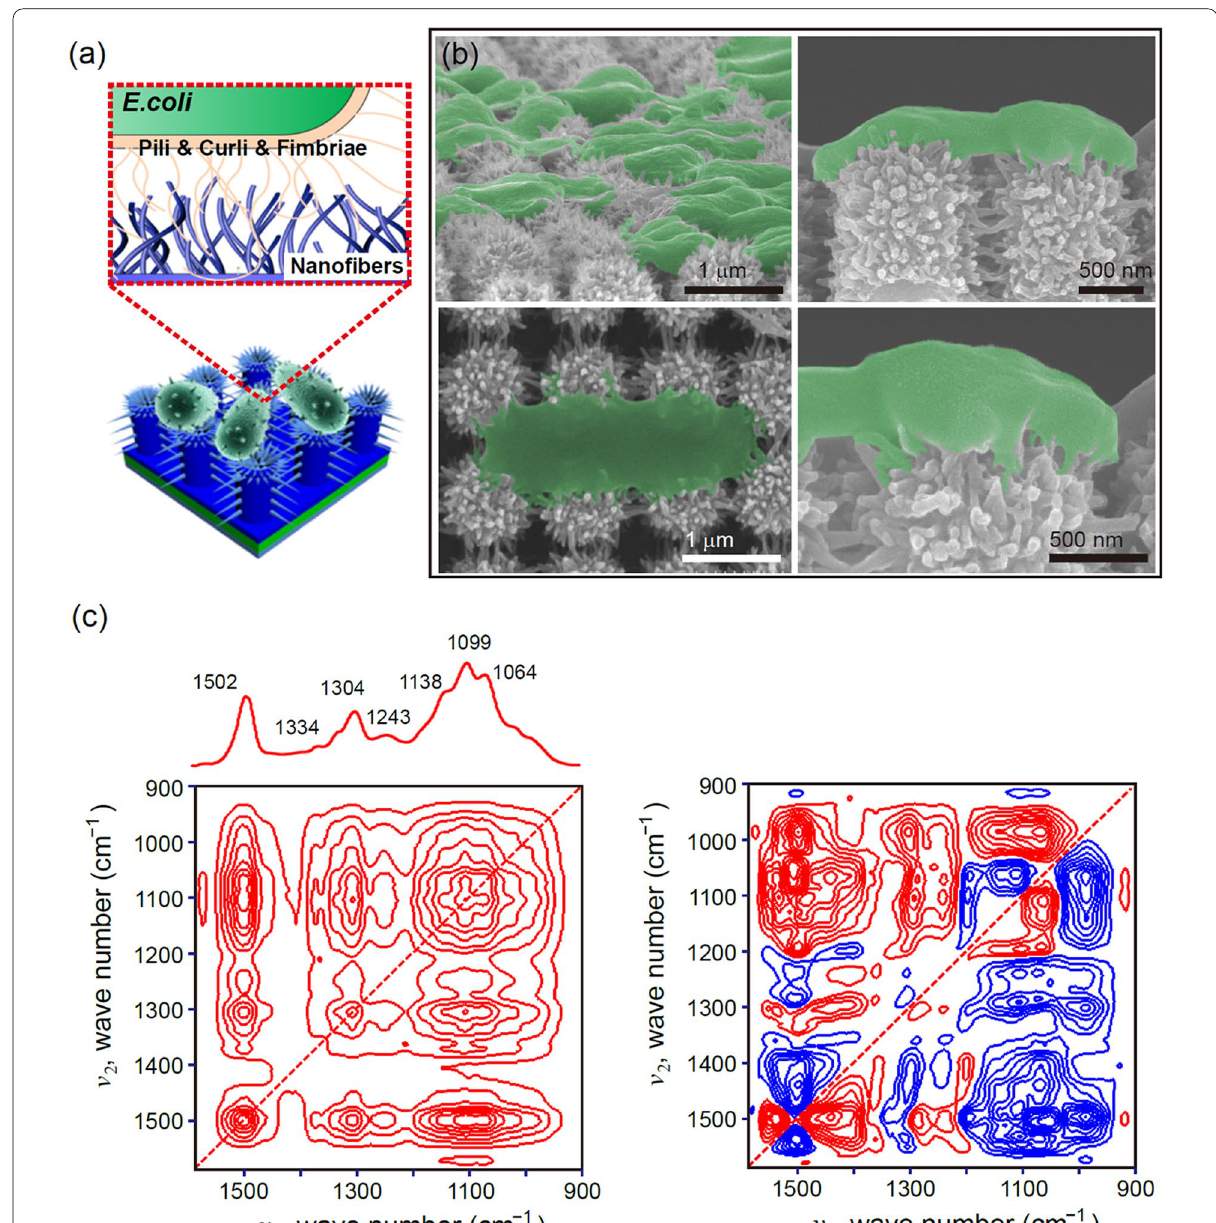
Fig. 3 a Schematic of interfacial interaction between the bacterial cells and the 3D HPN surface. b SEM images of 3D HPN captured E.coli O157:H7 cells under different magnifications. c Synchronous (left) and asynchronous (right) 2D correlations of the IR spectra of 3D HPN captured E.coli cells during E. coli O157:H7